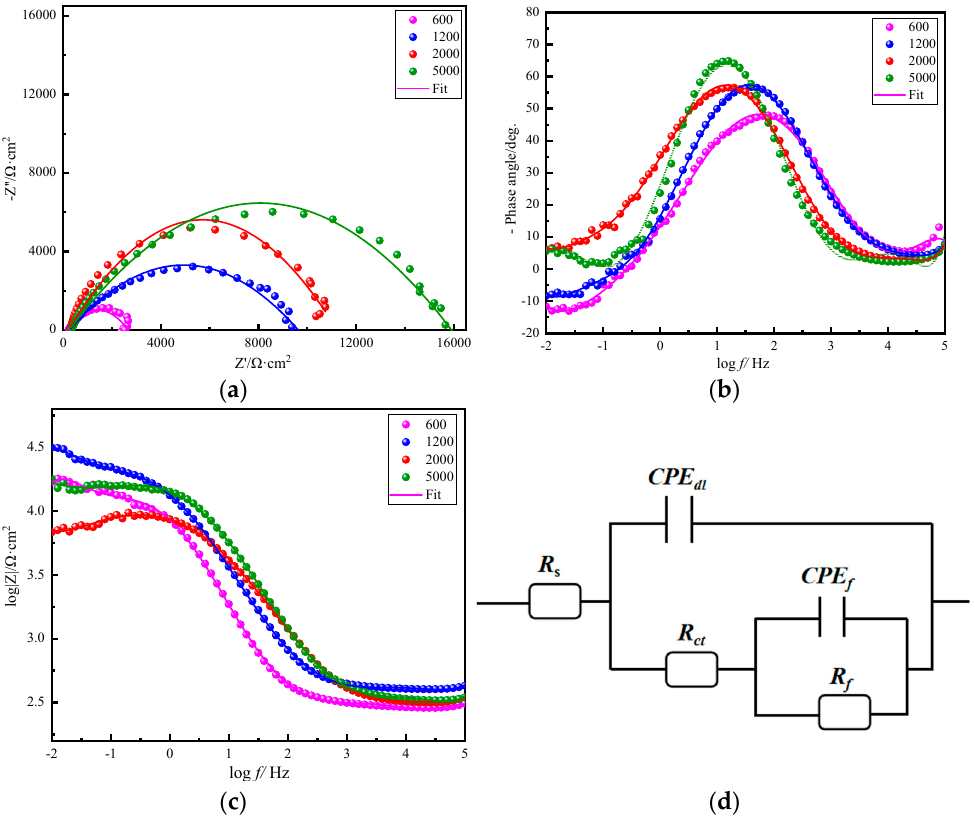
Figure 8. Nyquist diagram ( a ), bode magnitude plots ( b ), bode phase plots ( c ) and equivalent electrical circuit ( d ) of the studied system for ZnAl-LDH films grown on AZ91D magnesium alloy with different surface roughness. Table 2. Fitting results of the EIS spectrum depicted in Figure 6.